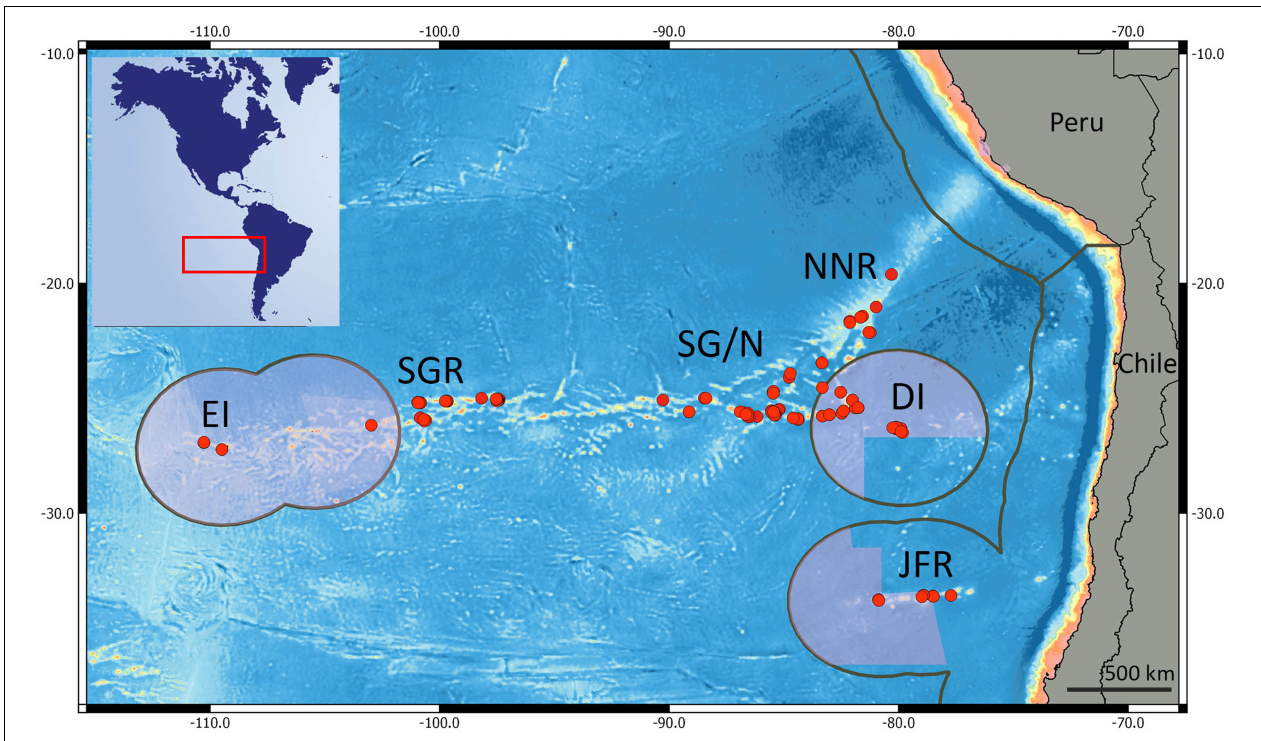
FIGURE 1 | Red dots represent the sampled stations on the southeast Pacific. EI, Easter Island; SGR, central Salas y Gómez Ridge; SG/N, Salas y Gómez and Nazca Ridge junction; DI, Desventuradas Islands; NNR, north Nazca Ridge, and JFR, Juan Fernández Ridge. Pink areas represent marine protected areas; Gray lines indicate the extent of the